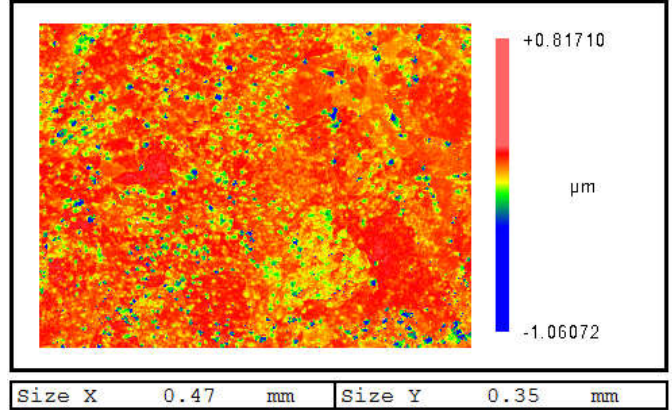
Figure 8. Surface morphology of aluminum with long time IBS.